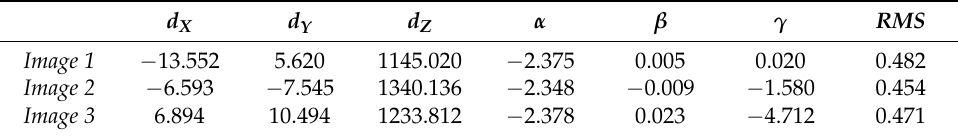
Table 2. Computed results for independent camera extrinsic approaches ( d x , d y , and d z in mm, and α , β , and γ in radians), given by the input data in Table 1, along with the optimization quality index for each minimized reprojection error vector (RMS in